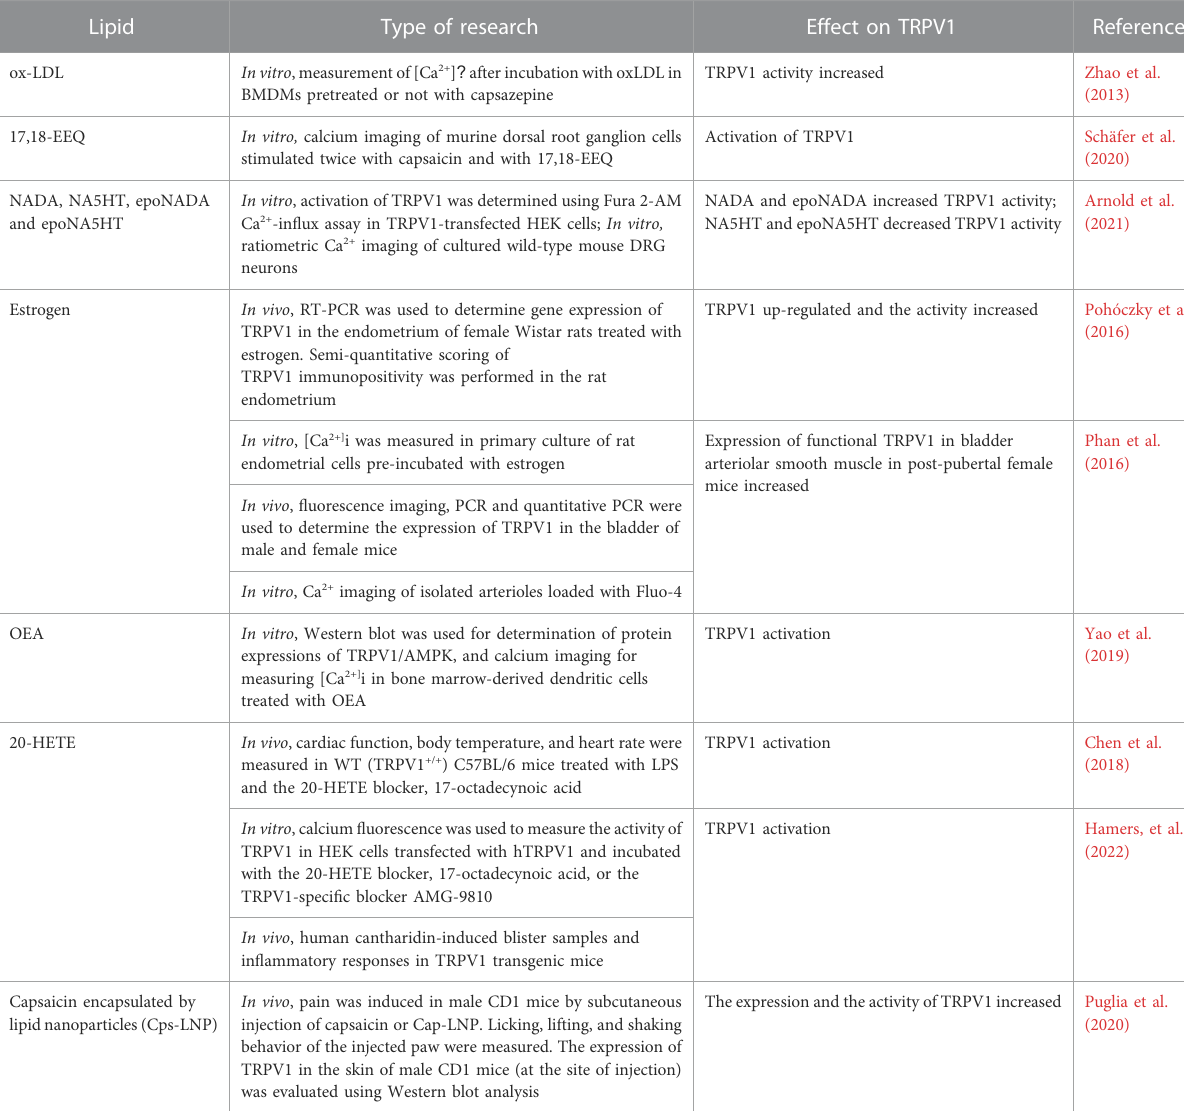
TABLE 2 Types of lipids affecting the expression and/or the activity of